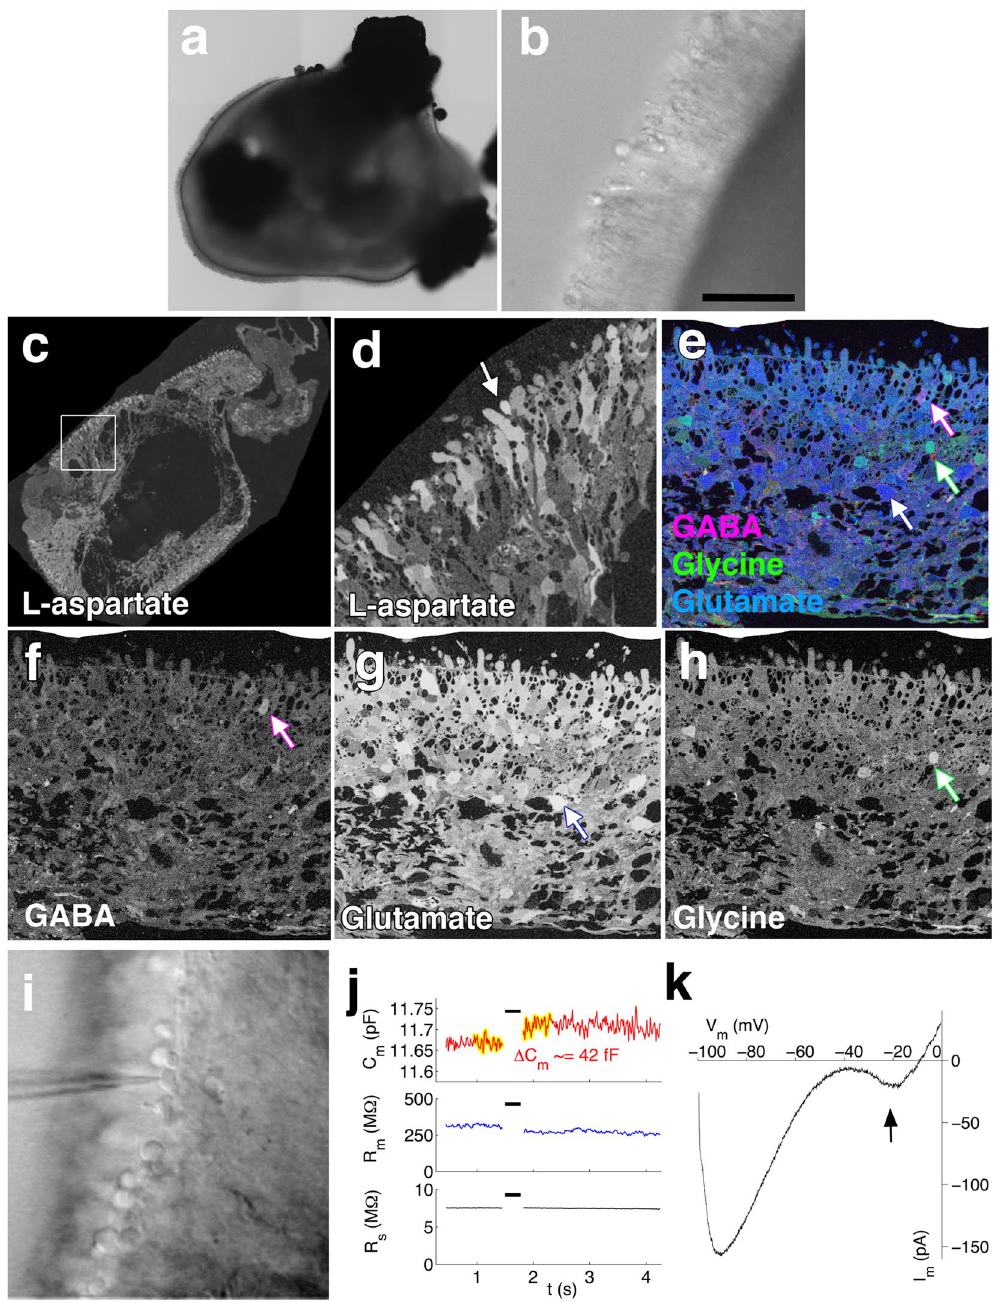
Figure 7. Metabolic labeling and electrophysiology of retina cups. Brightfield image of D300 IMR90.4 derived RC shown at ( a ) low and ( b ) high magnification. Immunolabeling of ultrathin plastic sections of RCs with antibodies against ( c , d ) L-aspartate, ( e , f ) GABA, ( e , g ) Glutamate and ( e , h ) Glycine on D300 RCs. Panel d is a higher magnification of the inset box from ( c ). Panel e is a triple label of GABA, glutamate and glycine. A DIC image of a RC in panel ( i ) illustrates a recording pipette used for capacitance measurements. ( j ) Upper panel: Lock-in membrane capacitance measurement of a cone photoreceptor from a PSC derived eyecup showed a capacitance “jump” upon a brief depolarization (indicated by the black bar) from − 60 mV to − 10 mV. The yellow highlights are regions before and after the stimulation from which the capacitance values are averaged. Middle and lower panels show stable membrane resistance and series resistance during the course of the recording, suggesting that the capacitance jump in the upper panel is not an artifact of conductance change, rather it reflects synaptic vesicle release. ( k ) In a whole cell recording of a cone photoreceptor, the voltage was held at − 60 mV, then stepped to − 100 mV, and increased to 0 mV at a ramp speed of 100 mV/250 ms (0.4 mV/ ms). The arrow points to the peak calcium current at − 20 mV, which is typical of L-type calcium currents in mammalian photoreceptors. Scale bars b = 40 μ